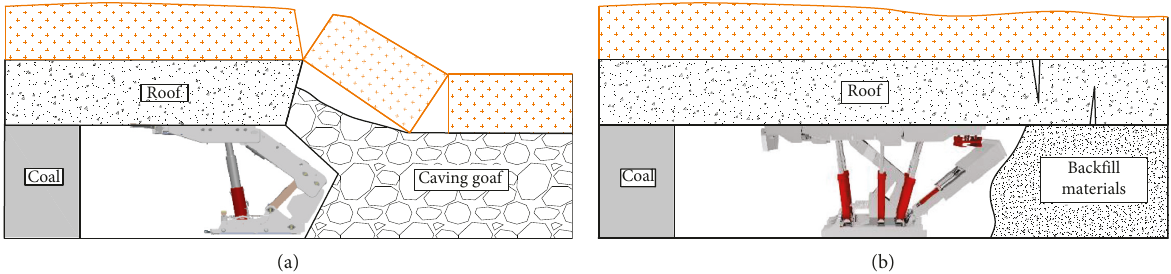
Figure 1: Surrounding rock-supporting system in caving stope and backfill stope. (a) Caving mining method. (b) Backfilling mining